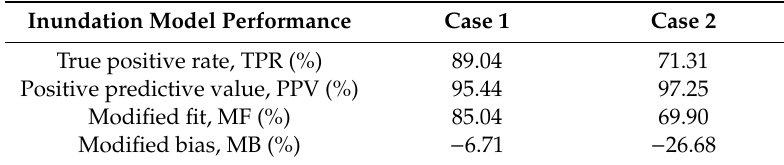
Table 5. Statistical evaluations of the flood inundation model based on inferred flood area at the two manhole locations (Case 1 and Case 2).